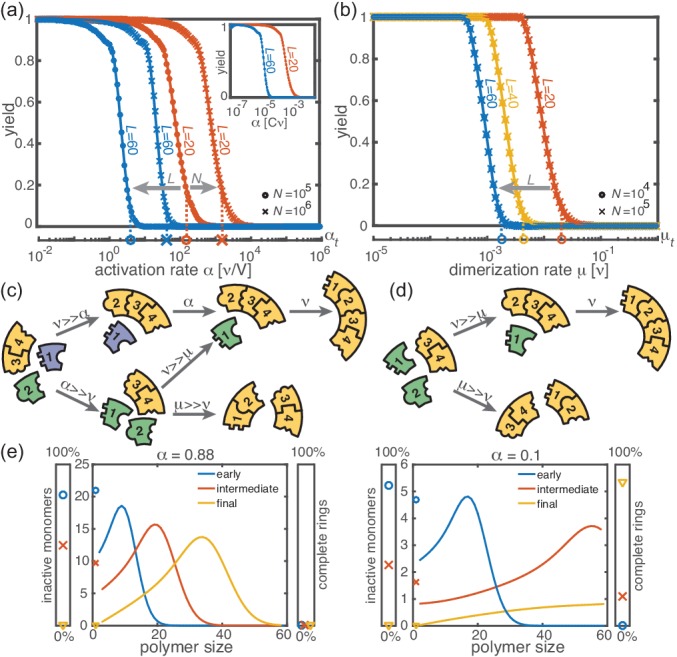
Deterministic behavior in the macroscopic limit N≫1.(a, b) Yield for different particle numbers N (symbols) and ring sizes L (colors) for Lnuc=2. Decreasing either (a) the activation rate (‘activation scenario’: μ=ν ) or (b) the dimerization rate (‘dimerization scenario’: α→∞) achieves perfect yield. The stochastic simulation results (symbols) average over 16 realizations and agree exactly with the integration of the chemical rate equations (lines). The threshold values (Equation 1) are indicated by the vertical dashed lines. Plotting yield against the dimensionless quantity α/(ν⁢C) causes the curves for different C to collapse into a single master curve (inset in a). For both scenarios there is no dependency on the number of species S in the deterministic limit. (c, d) Illustration showing how depletion traps are avoided by either slow activation (c) or slow dimerization (d). If the activation or the dimerization rate is small (large) compared to the growth rate, assembly paths leading to complete rings are favored (disfavored). The color scheme is the same as in Figure 1. (e) Deterministically, the size distribution of polymers behaves like a wave, and is shown for large and small activation rate for L=60, Lnuc=2, N=10000 and μ=ν=1. The distributions are obtained from a numerical integration of the deterministic mean-field dynamics, Equation 6, and are plotted for early, intermediate and final simulation times. The respective percentage of inactive monomers and complete rings is indicated by the symbols in the scale bar on the left or right.